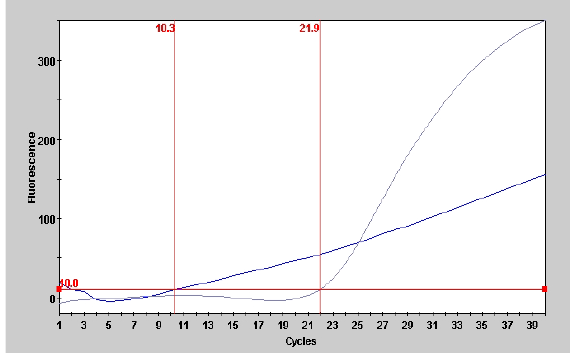
Figure, 1: RT- PCR amplification plot of G gene of ILT virus of two laryngeal and tracheal samples indicate positive result with FAM labeled probe: ILTV RT-PCR wild type for larynx and trachea of brown table egg layers (28 weeks old) from Jezera farm At Al- Siwara.